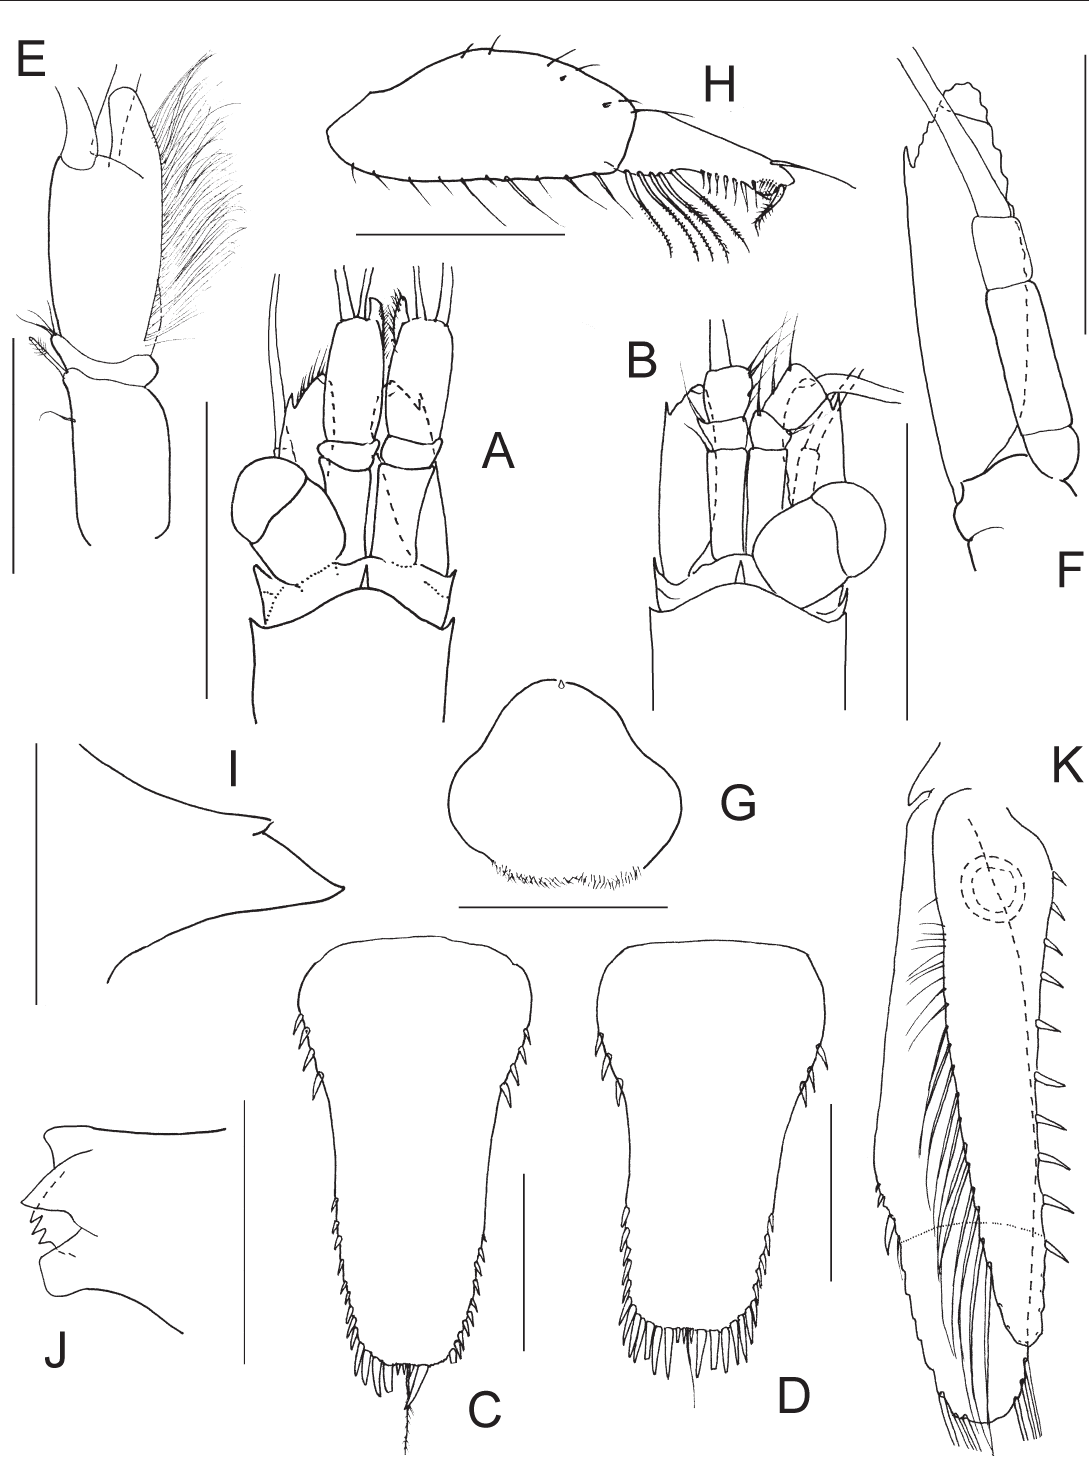
Fig. 11. Siriella hanseni W.M. Tattersall, 1922, Laccadive Sea, Gulf of Manaar, India. A . Anterior part of body (right eye not shown). B . Anterior part of body (left eye not shown). C . Telson (two posterolateral subterminal spiniform setae missing). D . Telson, paralectotype. E . Antenna 1 peduncle, dorsal view. F . Antenna 2, lectotype, ventral view. G . Labrum. H . Mandibular palp, lateral view. I . Left mandible. J . Right mandible. A, C, E–J = lectotype, ♂, length 5.5 mm; B, D = paralectotype, ♀, length 5.5 mm. Scale bars: A–B = 1 mm; E–F, K = 0.5 mm; C–D, G–H = 0.25 mm; I–J = 0.1